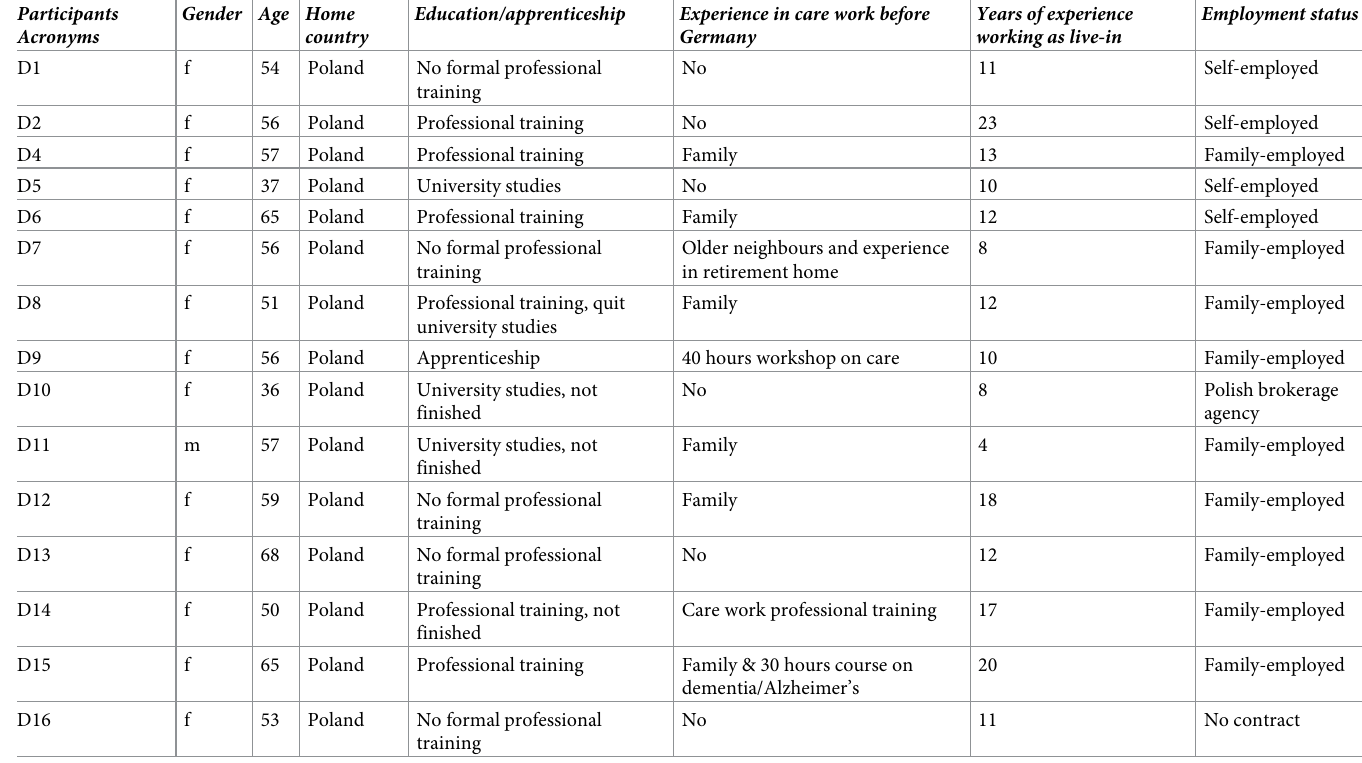
Table 1. Sociodemographic data, work experience and employment status of participants. Participants Gender Age Home Acronyms